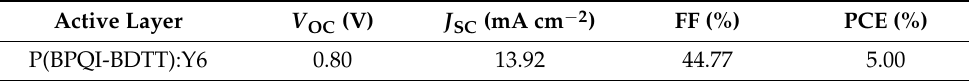
Table 3. Photovoltaic parameters of OSCs based on P(BPQI-BDTT):Y6’s active layer with its surface area of 1 cm 2 .